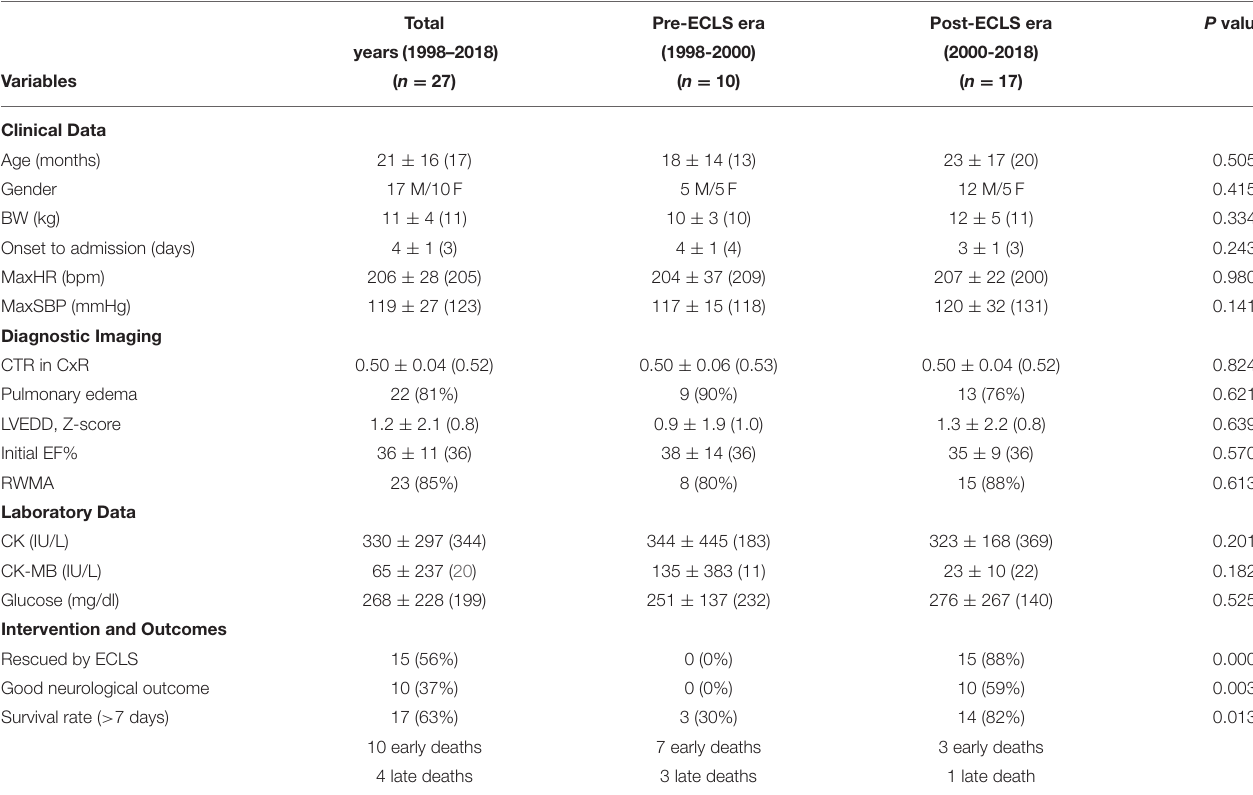
TABLE 1 | Comparison of cohort data from before and after the era of using ECLS to rescue severe EV71-related acute heart